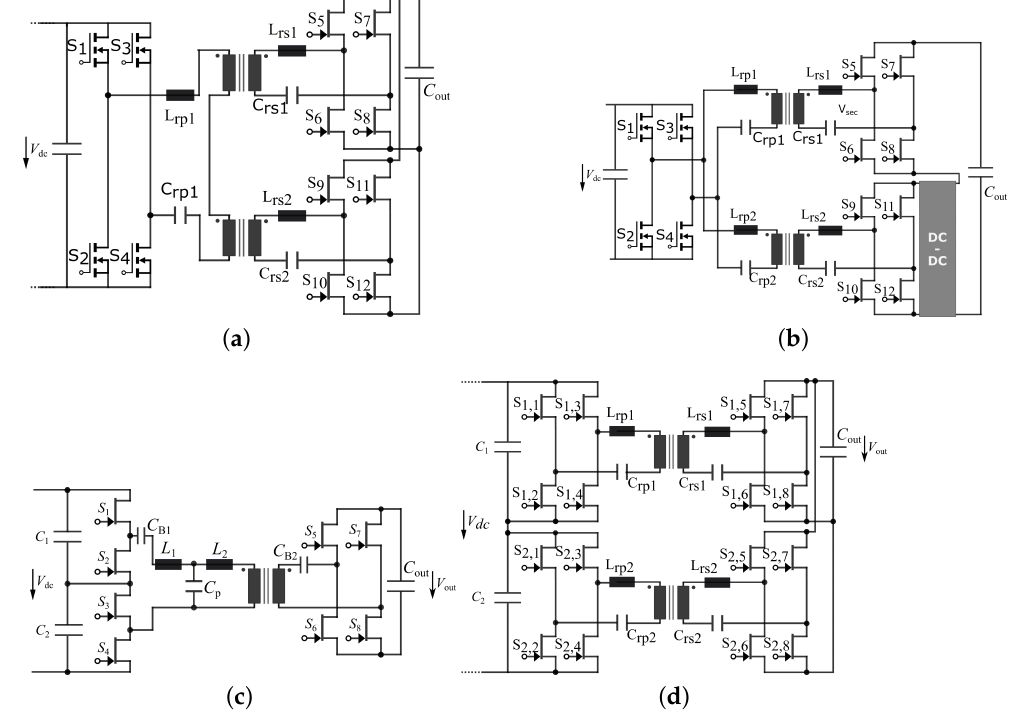
Figure 23. Bi-directional ( a ) hybrid resonant input-series output-parallel (ISOP) isolated resonant converter (derived from [90]), ( b ) input-parallel output-series (IPOS) isolated resonant partial power (PP) converter (derived from [156]), ( c ) LCL-T resonant converter [94], ( d ) (conceptual) SIPO resonant converter (edited from ([106]) for 400 V EV charging